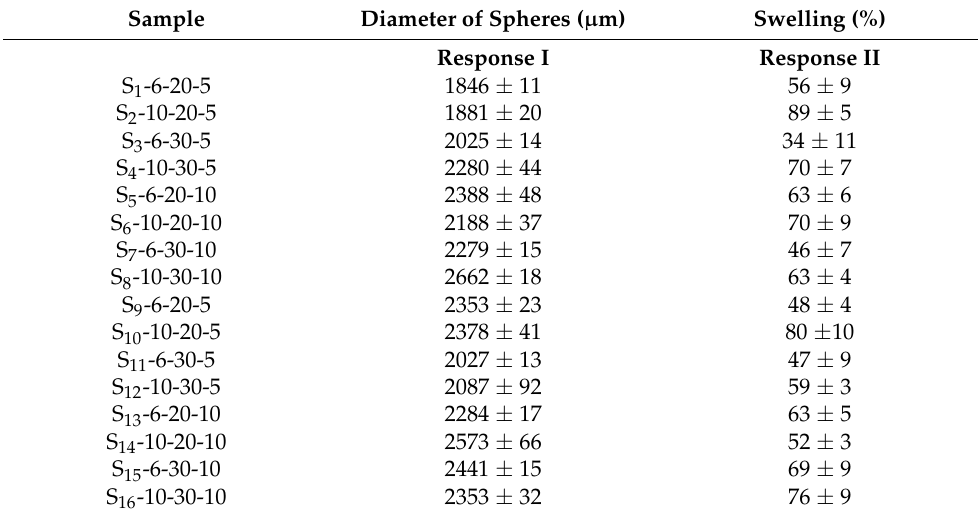
Table 4. Design of experiments (DOE) results for the samples of the experimental planning.